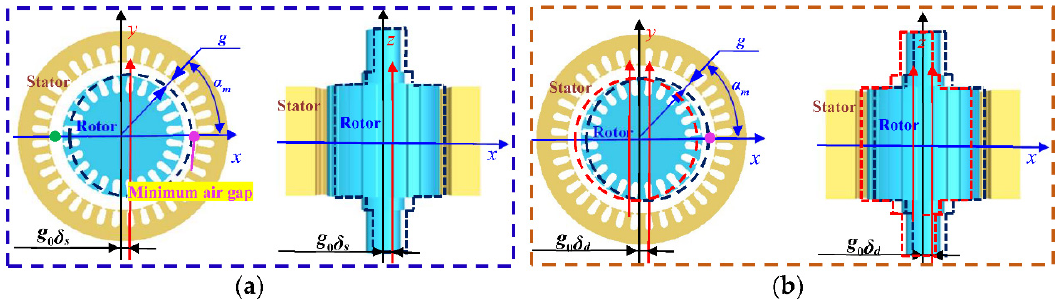
Figure 1. Schematic diagram of generator eccentricity: ( a ) RSAGE; and ( b ) RDAGE. PPUA can be obtained as